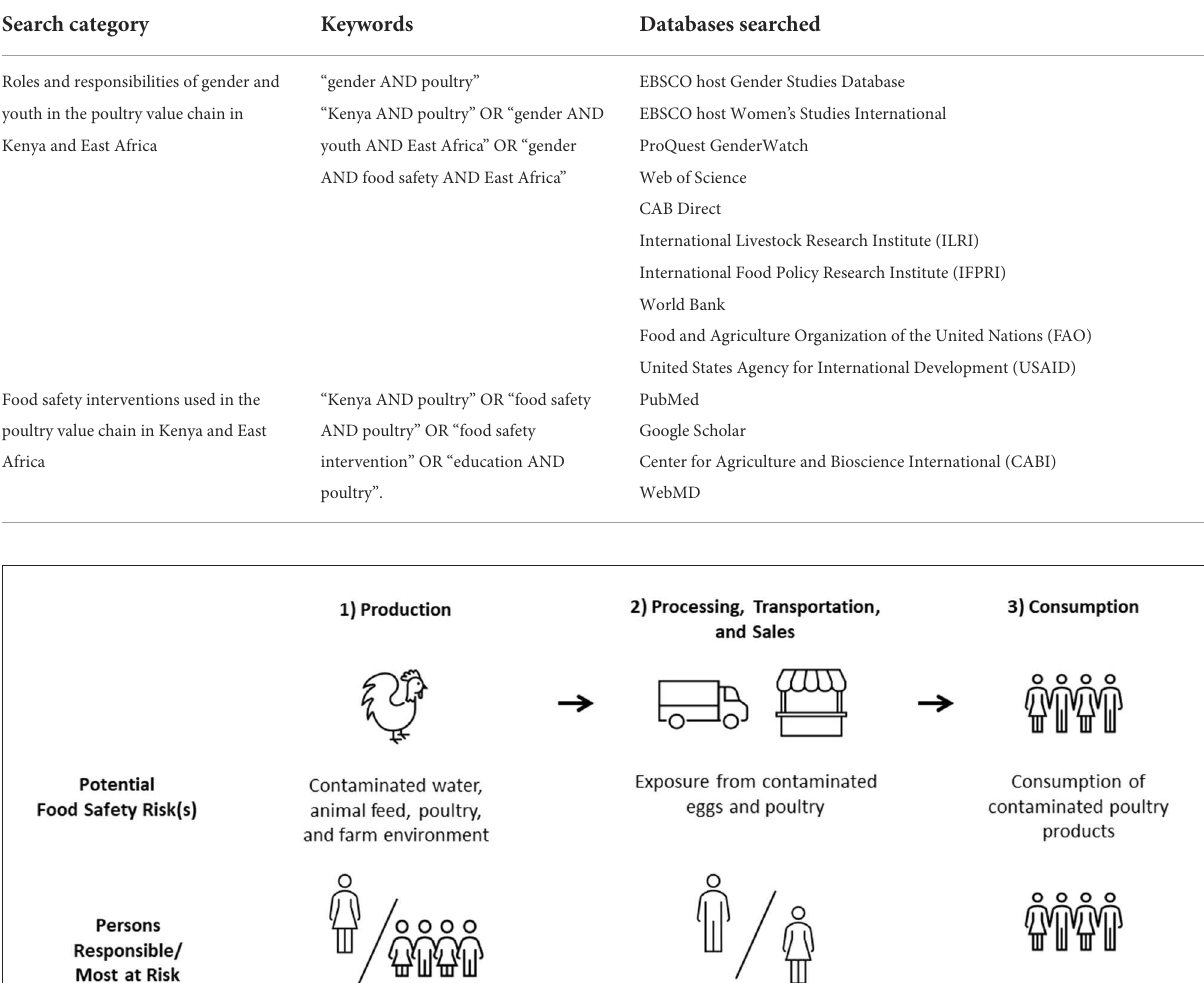
TABLE 1 Databases and key words used for literature search.